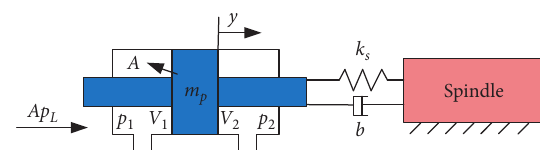
Figure 10: The elastic system considering stiffness and